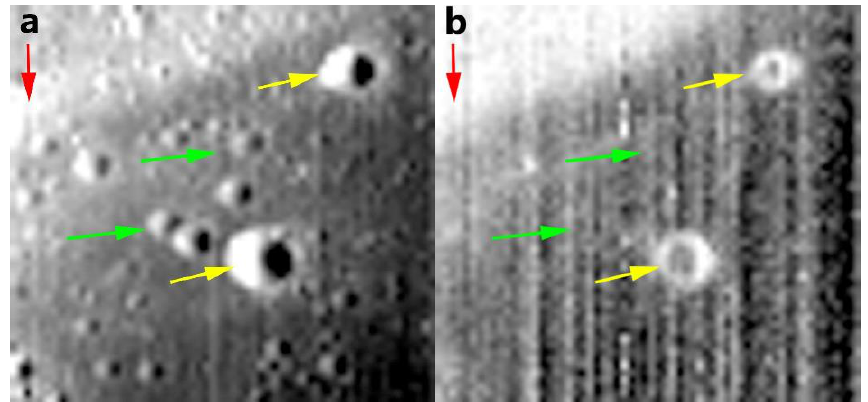
Figure 15. ( a ) M 3 750 nm reflectance image of one sub-area in Figure 14a (red box); ( b ) the ratio of 540 nm/810 nm SSA of this sub-area. Red arrow shows positively correlated bright swirl regions between the two images. Yellow arrows show some parts of crater wall or floor having higher brightness in the 750 nm reflectance image while having low values in the 540 nm/810 nm SSA ratio image. Green arrows show the craters disappeared in the 540 nm/810 nm SSA ratio image.